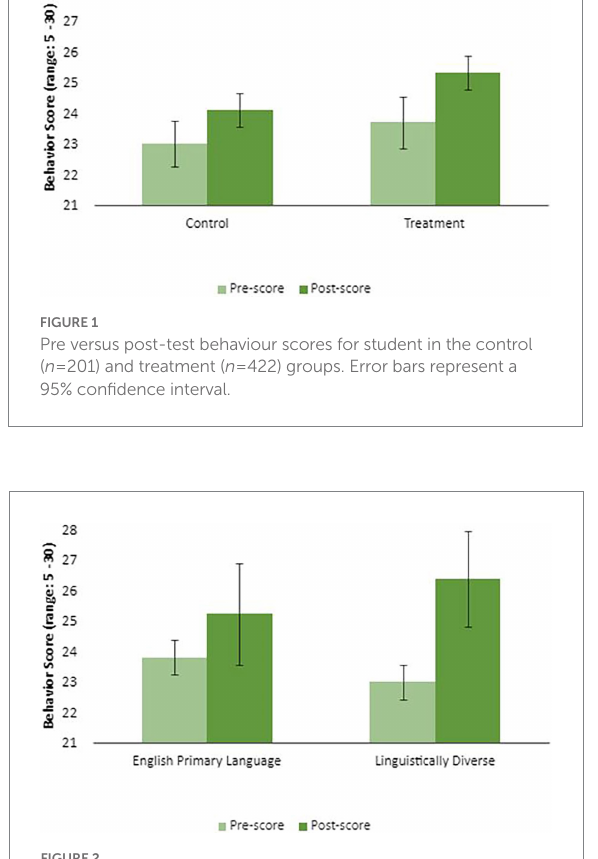
FIGURE 2 Pre versus post-test behaviour scores for student in the treatment group who responded that English was their primary language ( n = 366) and linguistically diverse students ( n = 46). Error bars represent a 95% confidence interval.